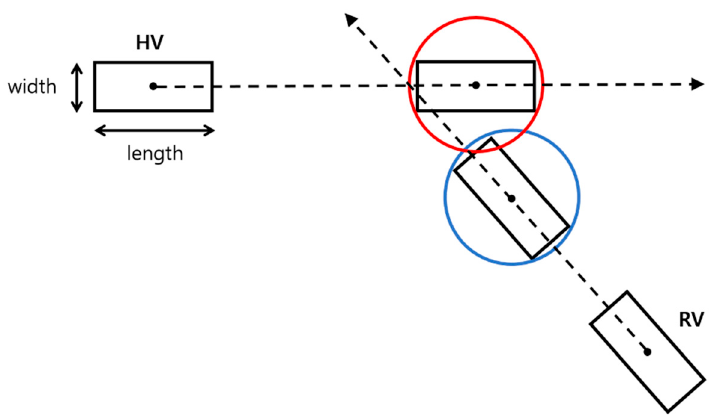
Figure 3. Illustration for finding a possible collision event using the predicted trajectories of the host vehicle and the remote vehicle.